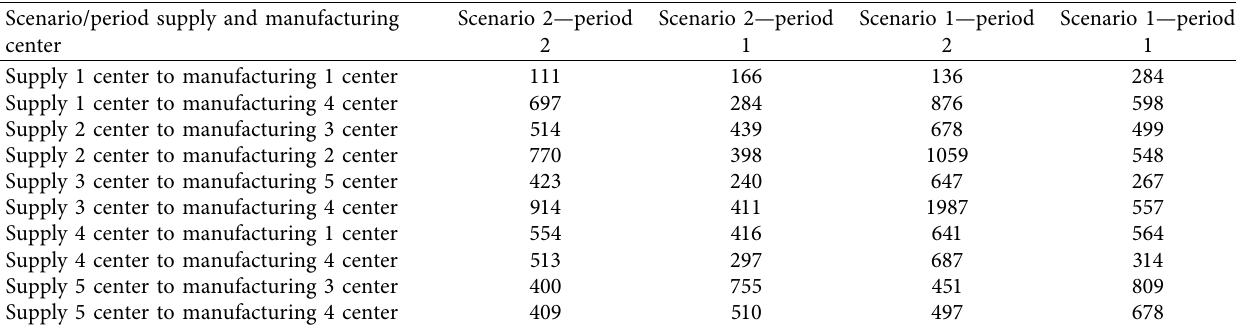
Table 9: The amount of product flow from supply centers to manufacturing centers.